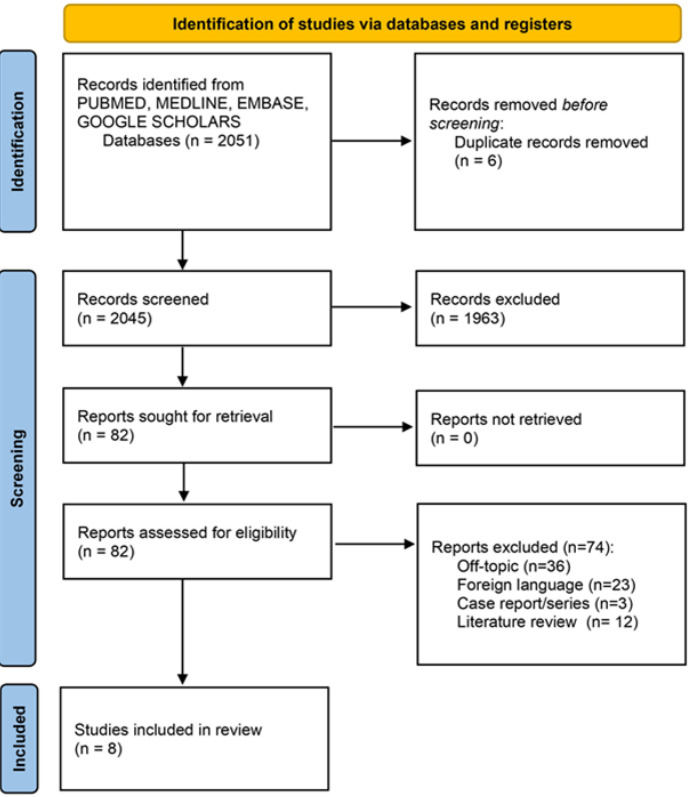
Figure 1. Summary of the screening process in accordance with the PRISMA guidelines [6].